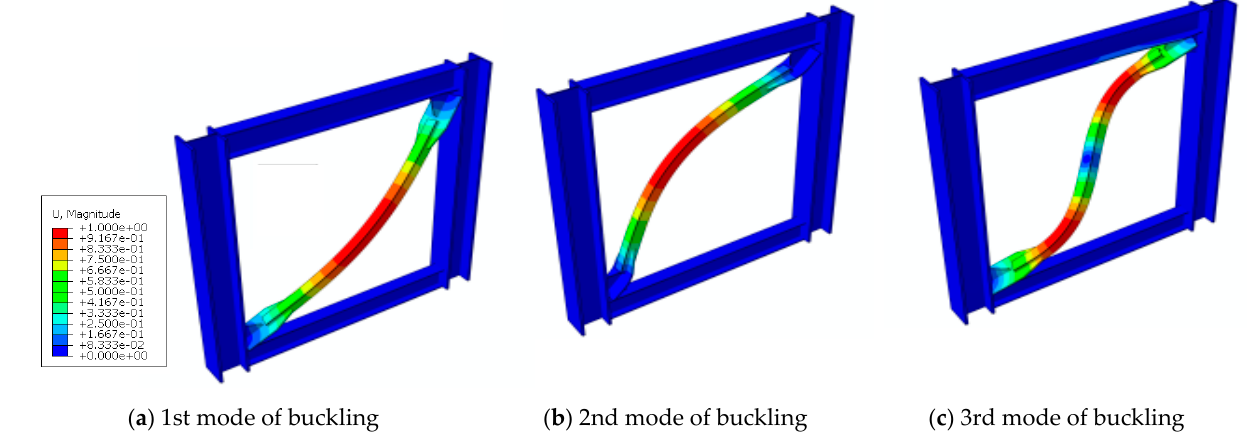
Figure 8. Modes of buckling. Figure 8. Modes of